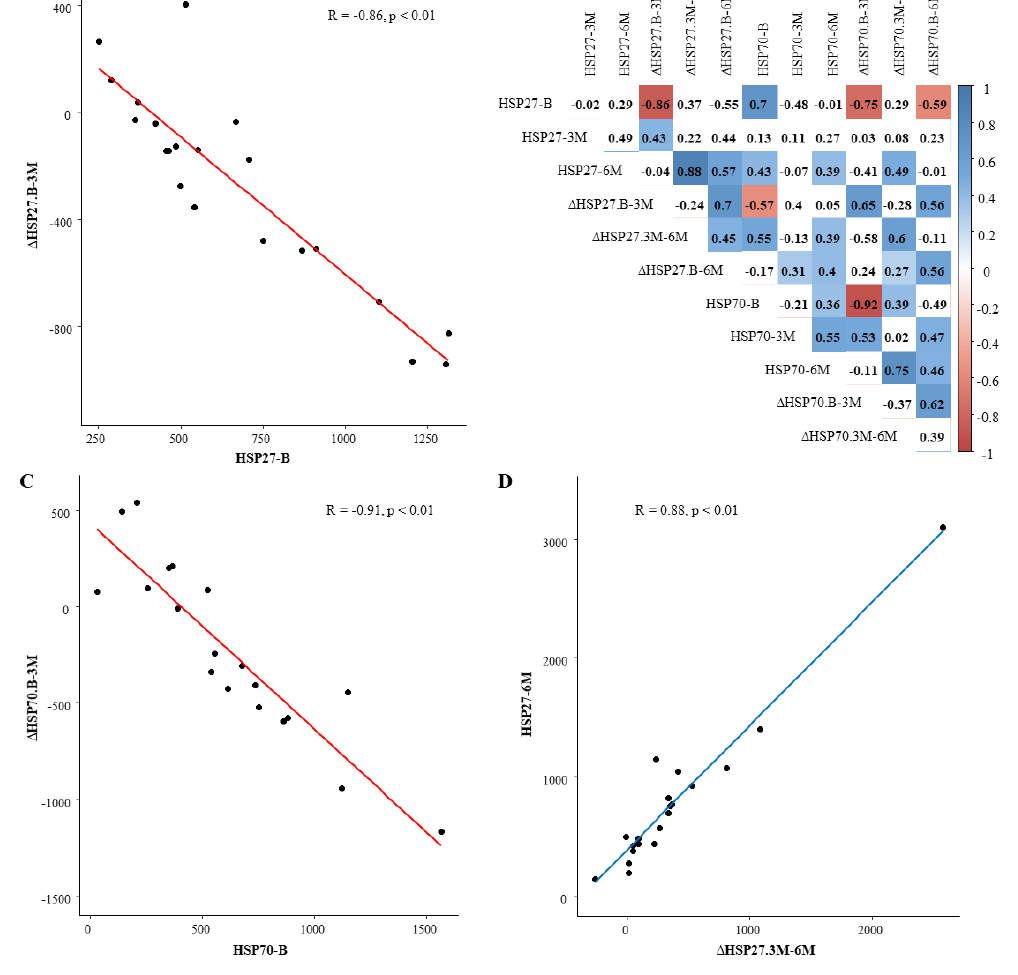
Figure 3. Relation between (∆) HSP27 and/or (∆)HSP70 levels during the study period. ( A ): Scatterplot with regression line for the relation between HSP27 at baseline and the ∆HSP27 from baseline to 3-month follow-up. The corresponding correlation coefficient and statistical significance are indicated in the graph. ( B ): Correlogram with correlation coefficients for all possible relations between (∆) HSP27 and/or (∆) HSP70. Significant correlations ( p < 0.05) are colored with either blue (positive correlation) or red (negative correlation). Variables with a strong correlation (−0.8 < R > 0.8) are visualized in the other panels. ( C ): Scatterplot with regression line for the relation between HSP70 at baseline and the ∆HSP70 from baseline to 3-month follow-up. ( D ): Scatterplot with regression line for the relation between ∆HSP27 from 3-month to 6-month follow-up and HSP27 at 6-month follow-up.